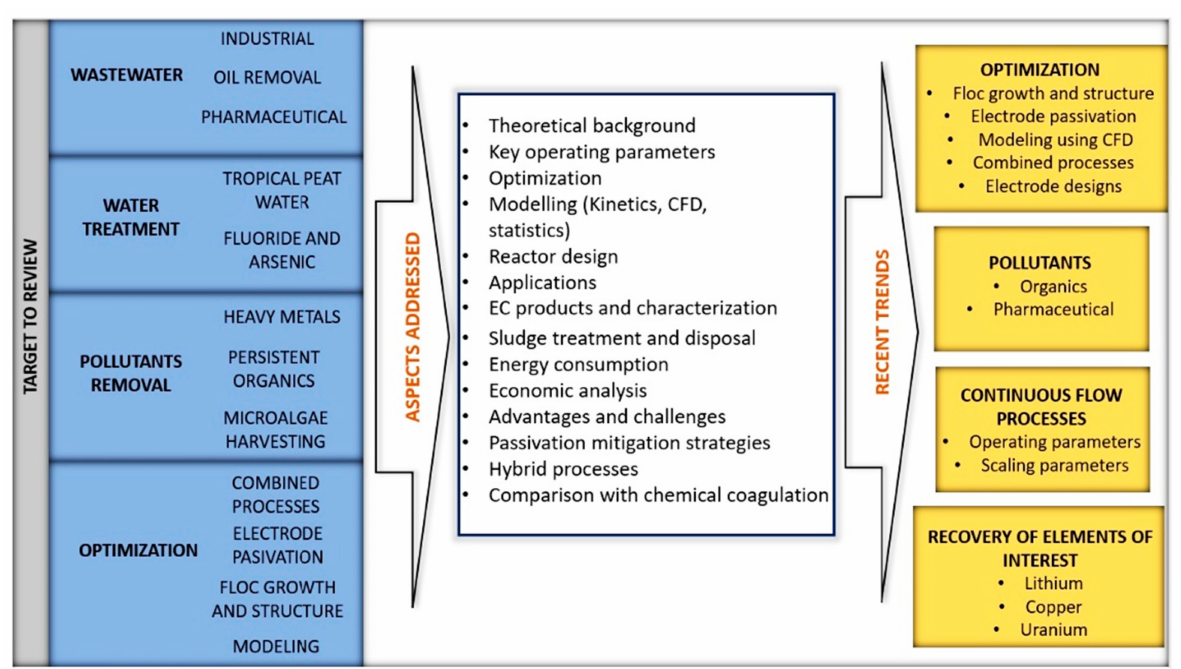
Figure 21. Targets, aspects addressed and recent trends of the EC